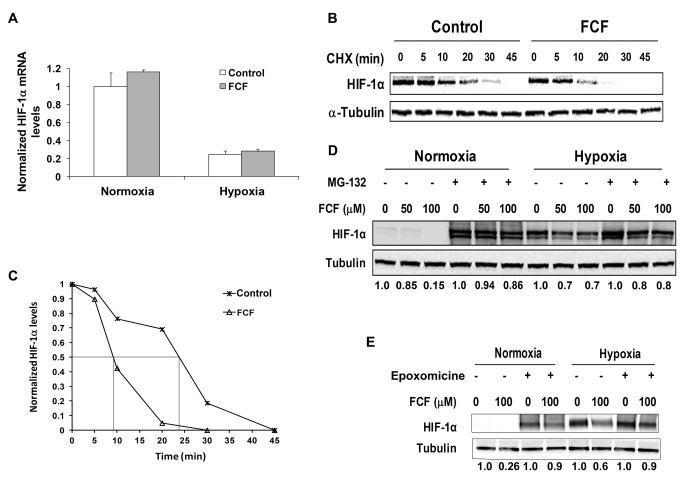
FCF affects HIF-1α expression on the posttranslational level.(A) PC-3 cells were pretreated with 100 μM FCF for 2 h and then subjected overnight to normoxic or hypoxic conditions. Total RNA was isolated and reverse transcribed into cDNA. Quantitative real-time PCR analysis was done using primers for HIF-1α and cyclophilin B as control. Columns, means (n = 2); bars, SD. (B) PC-3 cells were treated with vehicle (control) and 100 μM FCF for 4 h under normoxia, and then CHX was added at a final concentration of 10 μg/ml for the indicated times. Whole cell extracts were analyzed by SDS-PAGE and immunoblotted with antibodies to HIF-1α and tubulin. (C) Densitometric quantification of HIF-1α levels in (B) normalized to tubulin. Fifty% decrease of HIF-1α levels by FCF is delineated in grey lines. This is a representative experiment out of 3 independent repetitions. PC-3 cells were treated with FCF in the presence of 10 µM MG-132 (D) or 1 µM epoxomicine (E) for 2 h and then grown under normoxia and hypoxia for 4 additional h. Whole cell extracts were prepared, analyzed by SDS-PAGE and immunoblotted with antibodies to HIF-1α and tubulin. Densitometric quantification of HIF-1α/tubulin levels normalized to control at each condition is outlined under the respective lanes.